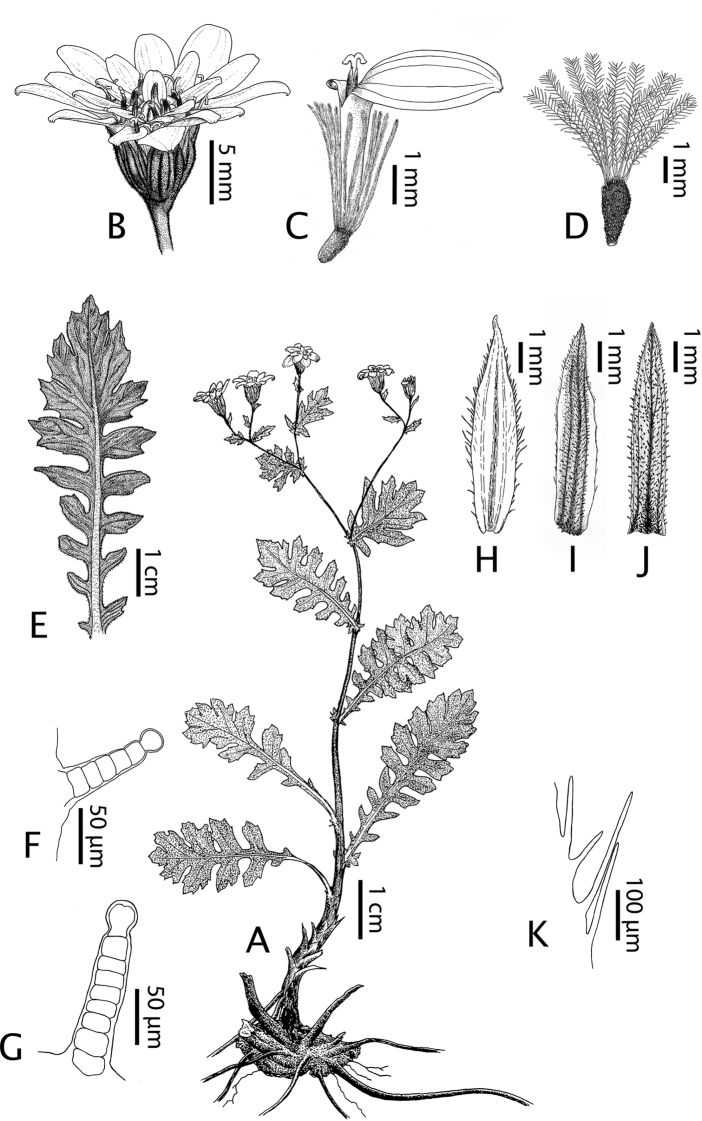
Leucheria
cantillanensis Lavandero, sp. nov. A habit B capitulum C detail of flower D fruit E basal leaf F leaf trichome G stem trichome H inner Middle involucral bract I middle Middle involucral bract J outer Middle involucral bract K ciliate margin of inner Middle involucral bract (detail). Illustrations by Benito Rosende.